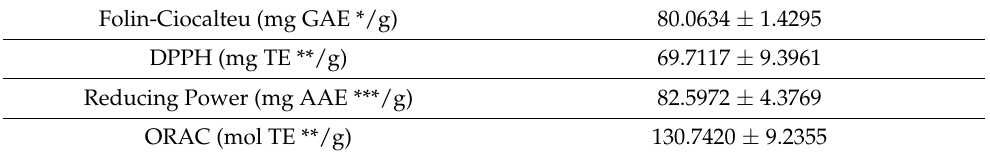
Table 3. Antioxidant activity of RGJe evaluated by abiotic assays. Results are reported as mean ± SEM of three experiments performed in triplicate and expressed in standard equivalent/g of dried